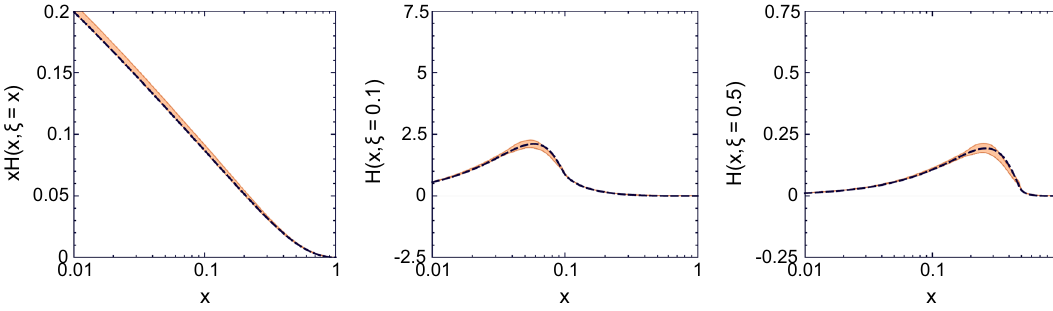
Fig. 6 Result of constraining the ANN model using 400 points eval- uated with the GK model [25–27] for sea quarks: x (cid:5)= ξ case, positiv- itynotenforced,allthreecontributions( F C (β,α), F S (β,α), F D (β,α) ) shown. See the text for more details. The comparison is for (left) ξ = x ,